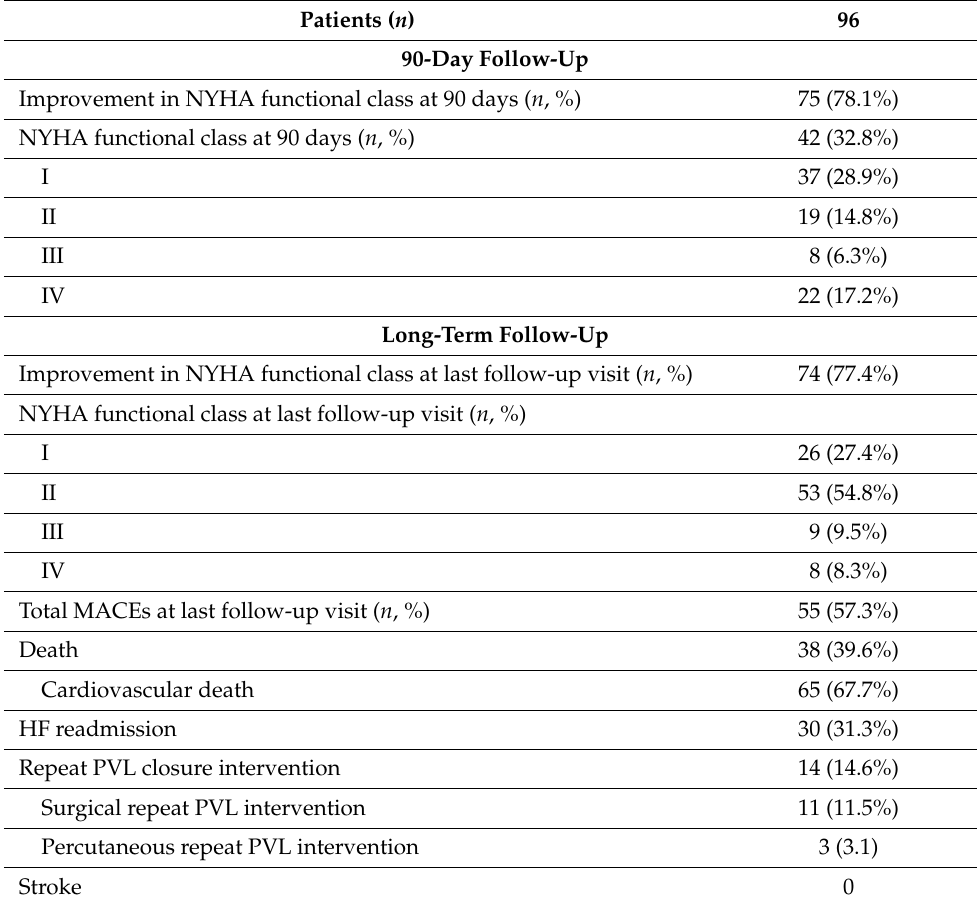
Table 4. Medium- and long-term